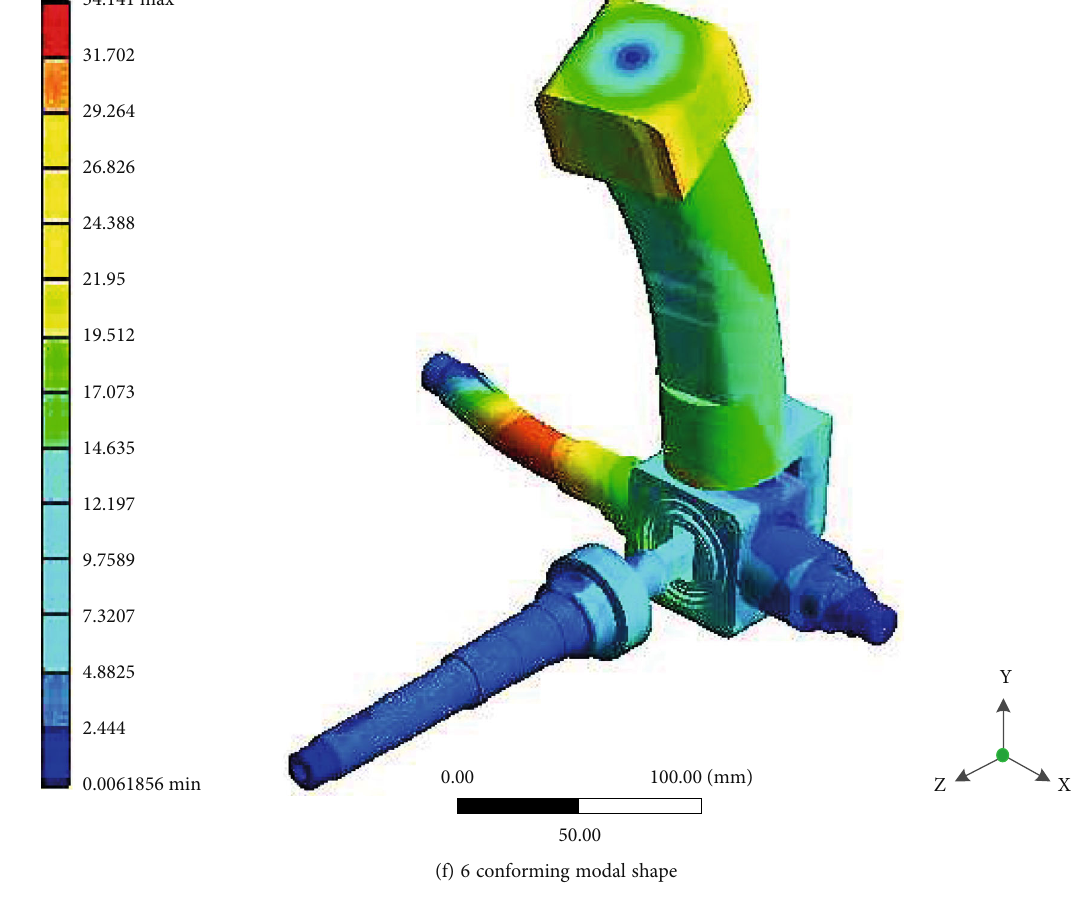
Figure 5: Vibration mode diagram of the fi rst 6 steps of operating isolation mechanism. Table 4: First six-order modal analysis results of operating isolation